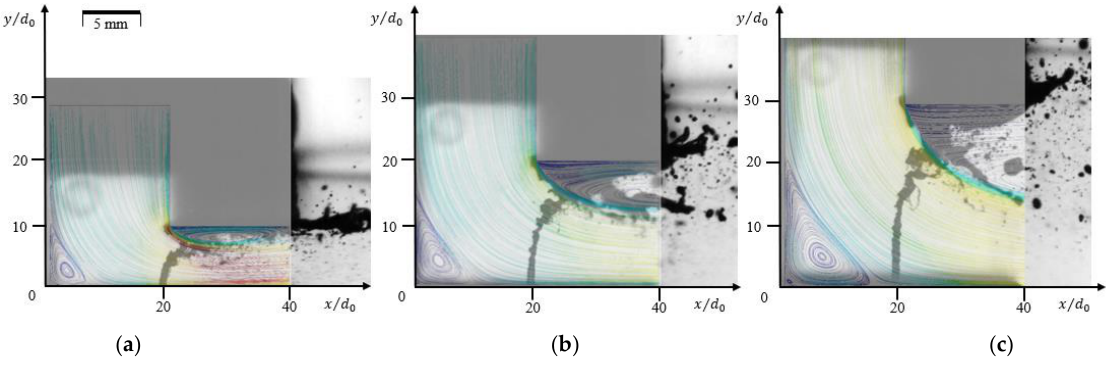
Figure 12. Velocity contours and streamlines with the fixed mass flow rate of 77 g/s and three different outlet heights: ( a ) H / d 0 = 10, ( b ) H / d 0 = 20, and ( c ) H / d 0 = 30.